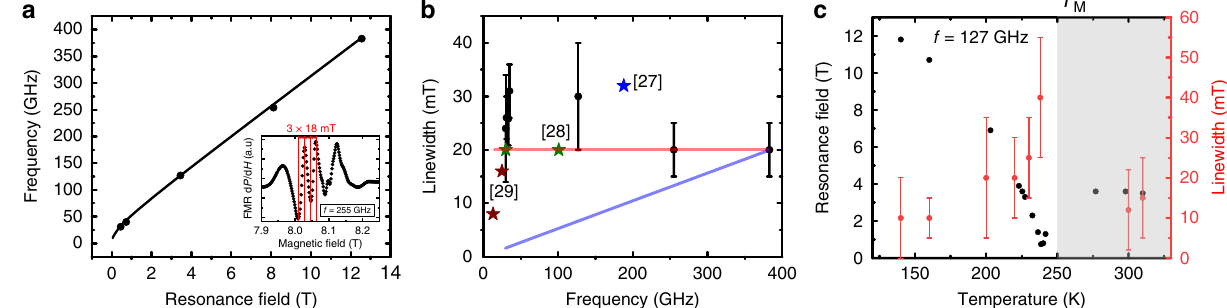
Fig. 3 Magnetic resonance and relaxation. a Resonance frequency as a function of magnetic fi eld for the low frequency mode of hematite at room temperature. Inset: resonance peak at 255 GHz for a 0.5 mm thick single crystal. b Linewidth as a function of frequency. The blue, brown and green points correspond to literature values from refs. 28 – 30 . Shadow red and blue lines correspond to theoretical calculations from two models from Fink et al. 31 with ( α = 10 − 6 ) and without ( α = 10 − 5 ) a dependence of AFM linewidth on the anisotropy. c Resonance fi eld and linewidth as a function of temperature for an excitation frequency of 127 GHz. Error bars correspond to peak